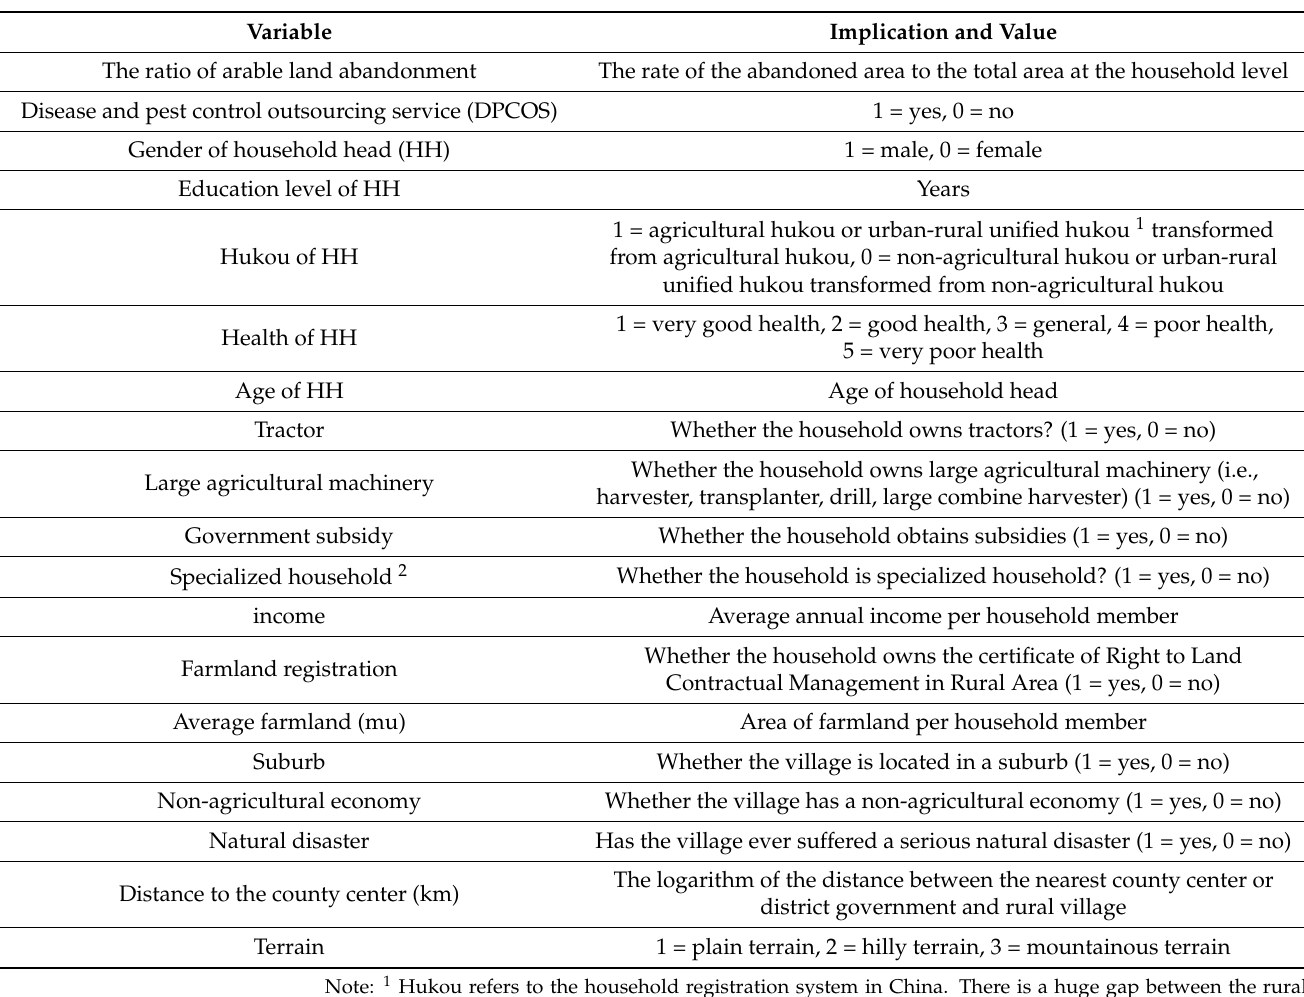
Table 1. Definitions of variables.